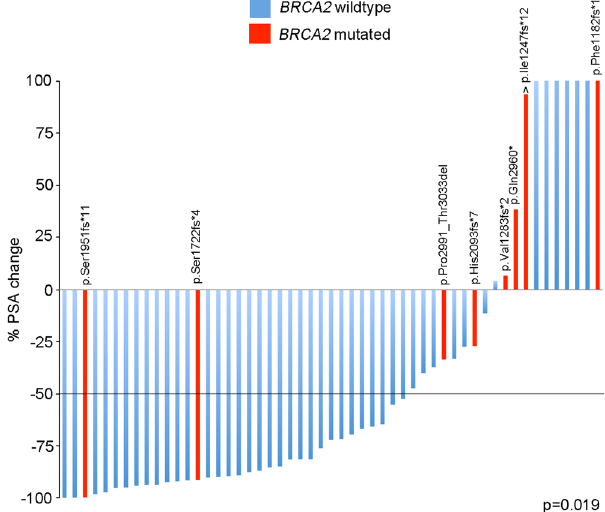
Figure 1. BRCA2 mutation status and response to docetaxel. Waterfall plot showing the PSA responses (% PSA change) in 53 men with primary metastatic or locally advanced prostate cancer. The dotted line indicates the threshold for defining a PSA response (PSA decline ≥ 50%). Changes in the protein coding sequence are given for all patients with a BRCA2 mutation. There was a statistically significant correlation between the presence of a BRCA2 mutation and the response to docetaxel (p = 0.019, Fisher’s Exact test). The circumflex denotes a patient who carried a known germline BRCA2 mutations that was also present in the tumor and whose course of disease has previously been reported 29 . The y axis was cut off at